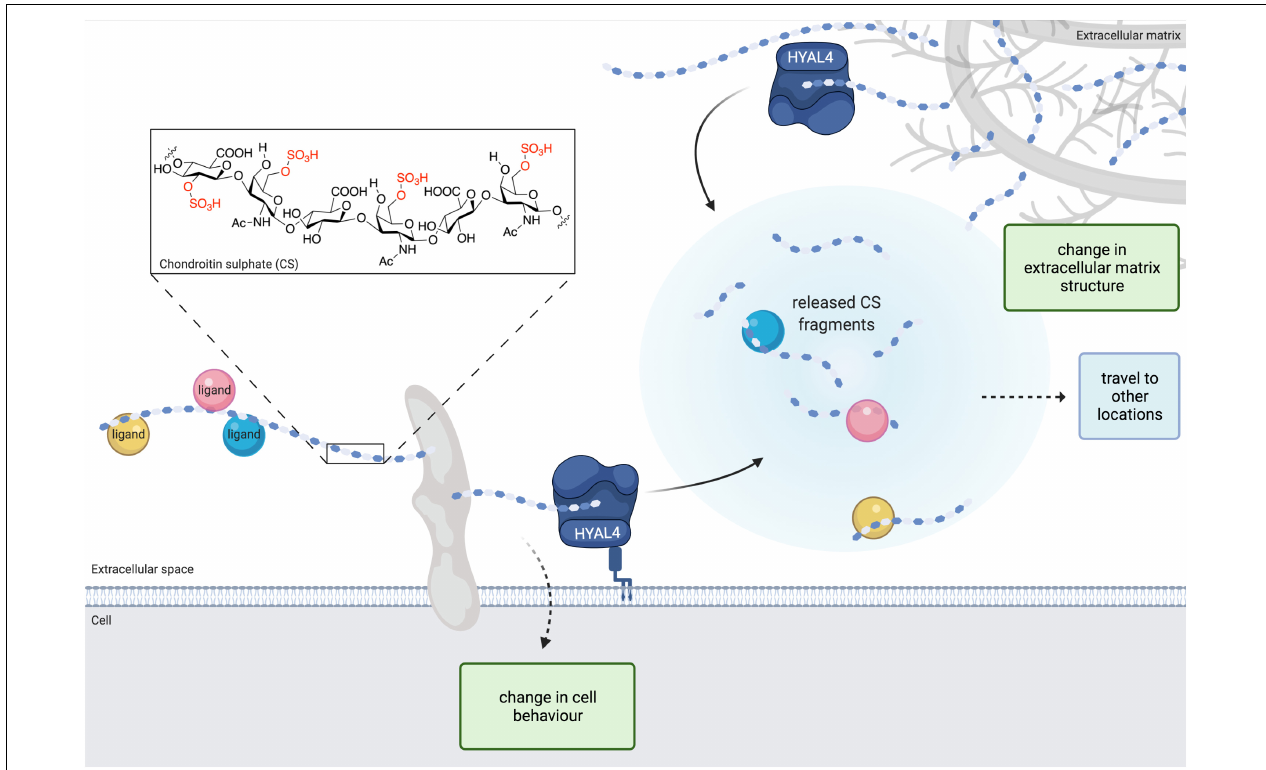
FIGURE 1 | The structure of chondroitin sulphate (CS) is modified by hyaluronidase 4 (HYAL4)/chondroitin sulphate hydrolase (CHSE) degradation activity. Image depicts HYAL4 modification of cell surface and extracellular matrix CS proteoglycans (CSPGs). CS side chains are cleaved by HYAL4 to produce free oligosaccharides and a shorter parent chain. Released CS fragments and ligand cargo are free to travel to different locations and exert changes on other cells. The modified parent CSPG also modifies cell behaviour. Removal of CS from the extracellular matrix induces changes in tissue structure. Inset, chemical structure of CS with example sulphate groups highlighted in red. Figure created with